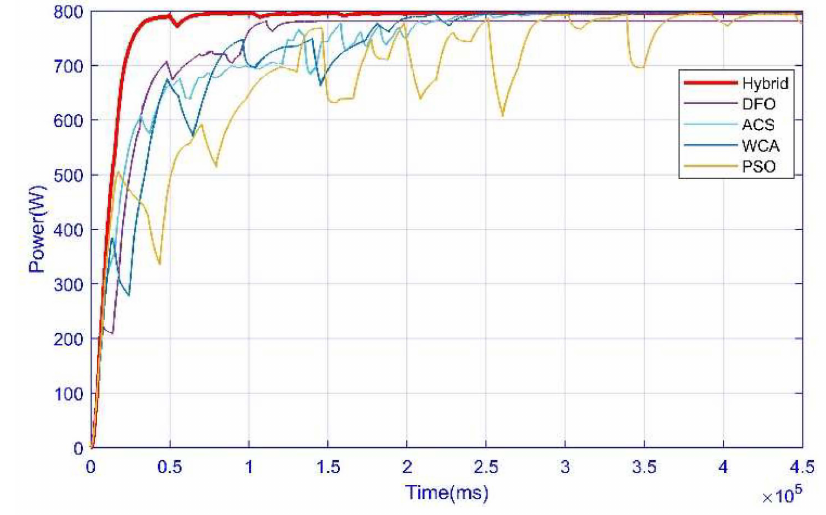
Figure 9. Case 2: Power comparison of hybrid with other